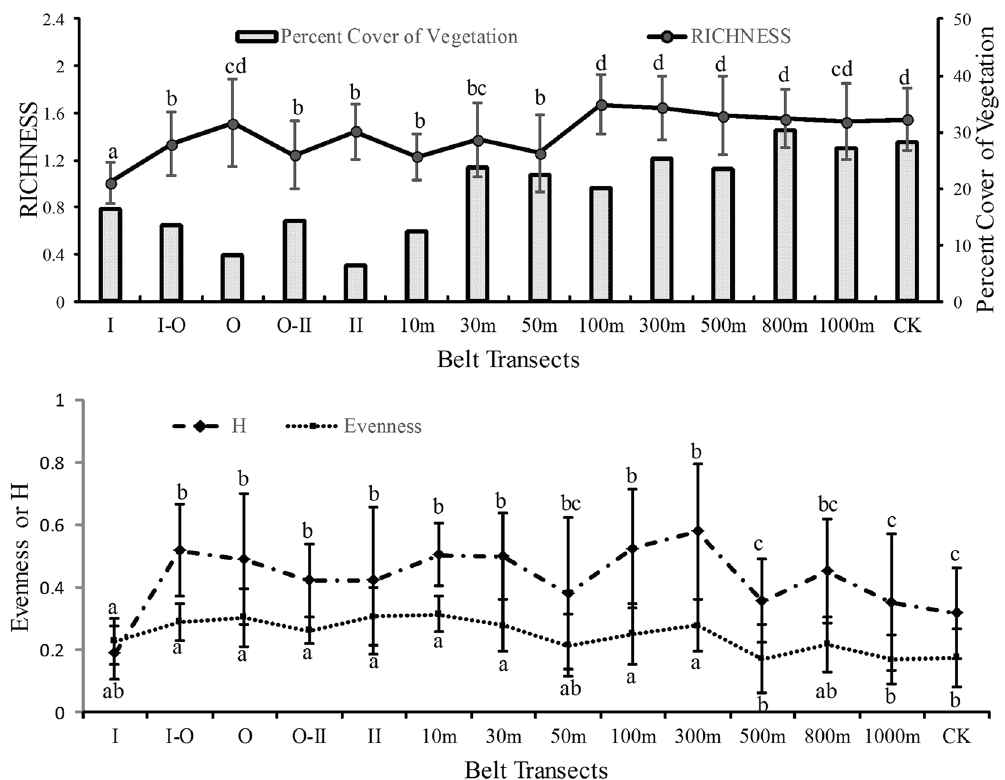
Figure 3. Changes in RICHNESS, Percent Cover of Vegetation, H and Evenness of the plant communities in the belt transects. CK was the Control Belt Transect which was at least 2 km north from the pipeline area and was rarely affected by human disturbance. For each index, bars marked with the same letter are not significantly different from each other at the p = 0.05 level. The bars of H are marked letters below, while the bars of Evenness are marked above. The bars showed + / −